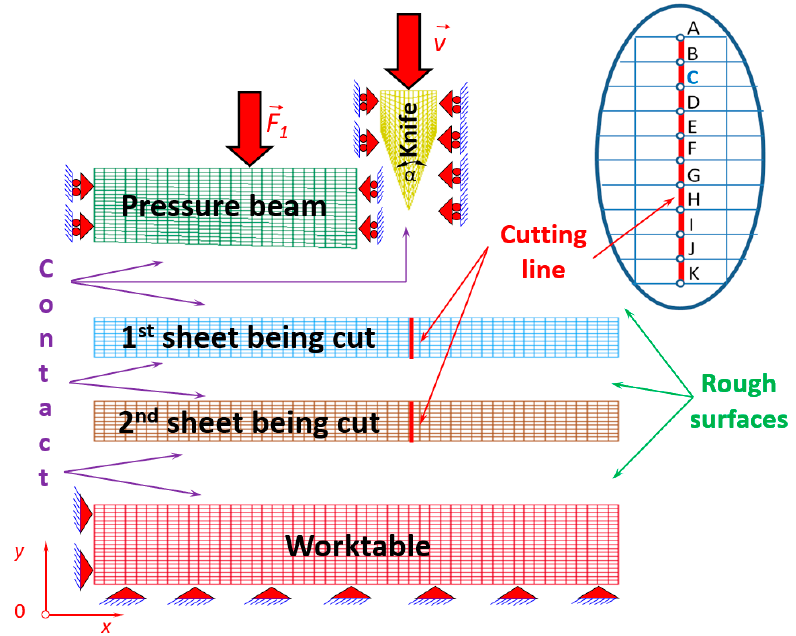
Figure 2. Mesh of the station for carrying out the cutting process with nodes belonging to the cutting line and represented by letters from A to K.